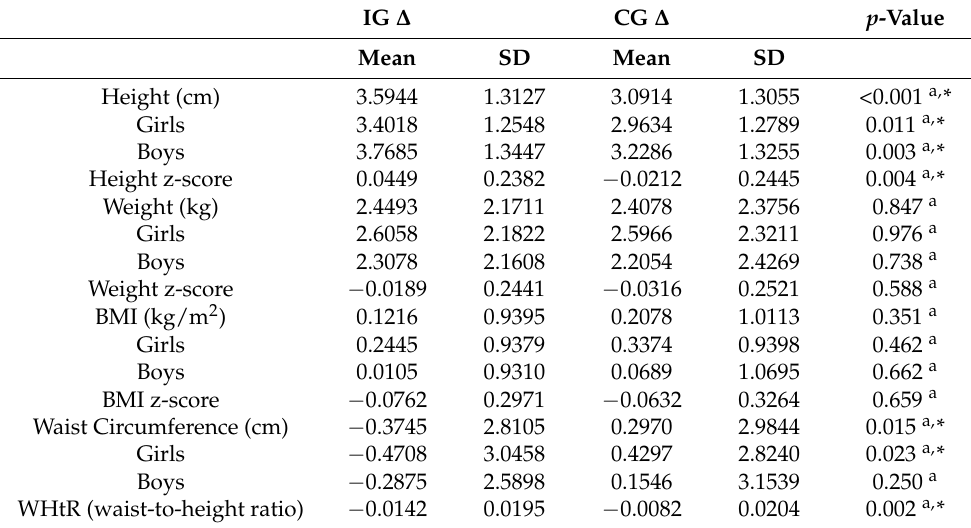
Table 3. Changes in anthropometric measures for intervention ( n = 219) and control group ( n = 230). IG